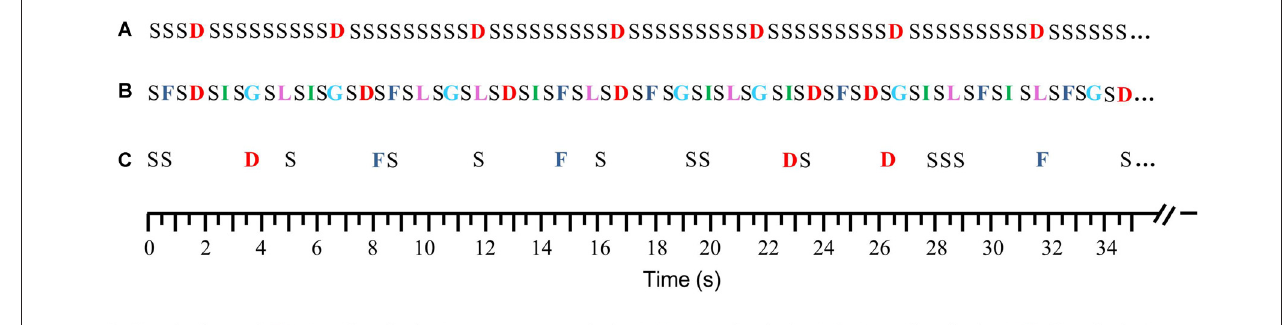
FIGURE 1 | Schematic illustration of the auditory paradigms, compared to the traditional oddball paradigm, which was not used in the study. (A) Traditional oddball paradigm (SOA = 0.5 s), (B) Optimum–1 (Opt–1) paradigm (SOA = 0.5 s), and (C) Memory Trace (MemTra) paradigm (ISI = 0.5, 1.5, and 3 s; ISI standard - deviant = 3 s).